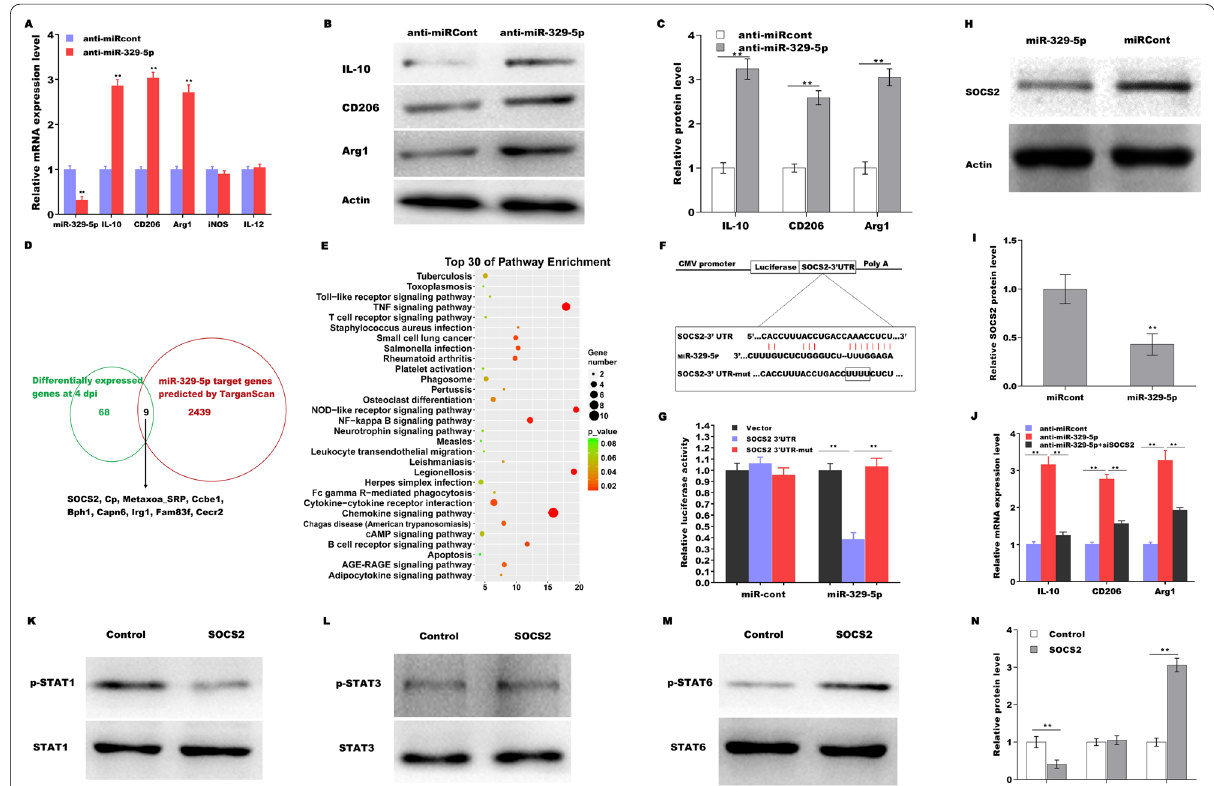
Fig. 6 MiRNA-329-5p regulates macrophage activation by targeting SOCS2-STAT1/6 signaling. qRT-PCR ( A ) and western blot ( B and C ) analysis of IL-10, CD206, and Arg1 expression in U937 macrophages after miRNA-329-5p inhibition for 48 h. D A Venn diagram analysis of overlapping mRNAs in both sets of data. E KEGG analysis of DEmRNAs between crushed sciatic nerves and intact contralateral nerves. F Schematic representation of the miRNA-329-5p site in the SOCS2-3 ʹ UTR. G Luciferase activity was assayed in HEK293 cells after cotransfection with miRNA-329-5p and luciferase reporters containing the SOCS2-3 ʹ UTR. H and I Western blot and quantitative analysis of SOCS2 in U937 macrophages after miRNA-329-5p inhibition. J qRT-PCR analysis of IL-10, CD206, and Arg1 expression in U937 macrophages after miRNA-329-5p inhibition in the presence or absence of siSOCS2. K – N Western blot analysis of p-STAT1, p-STAT3, and p-STAT6 in U937 macrophages after SOCS2 overexpression for 48 h. * p < 0.05. ** p <